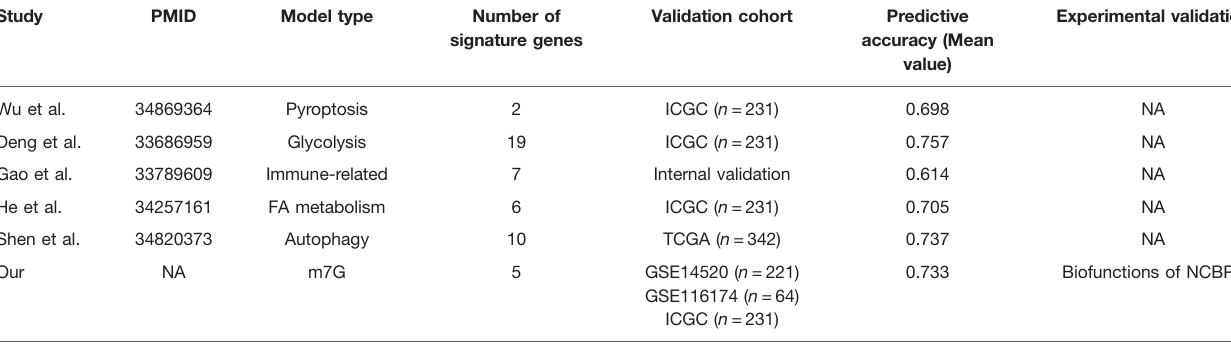
TABLE 3 | Comparison between fi ve related research studies and our